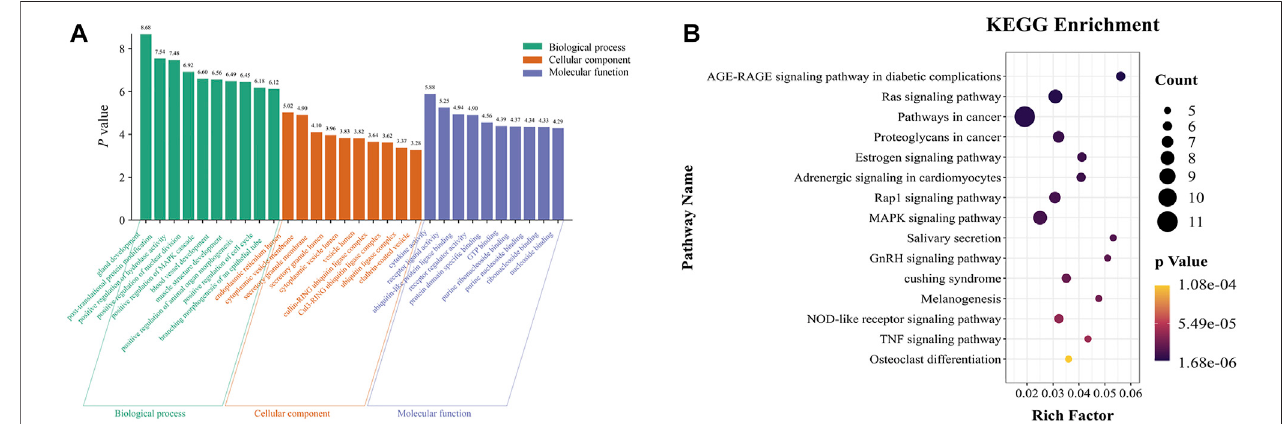
FIGURE 4 | GO and KEGG pathway analysis of the 94 core targets. (A) Top 10 signi fi cantly enriched GO terms. (B) Top 15 signi fi cant KEGG pathway